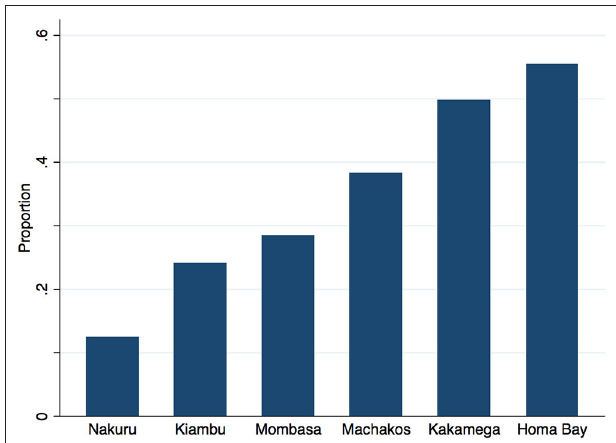
FIGURE 2 | Proportion of clients in lowest two urban quintiles, by